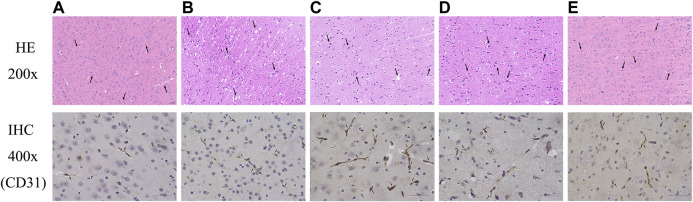
FYXN improved morphology and promoted angiogenesis in DMCI rats. Representative images of HE and immunohistochemistry are shown as follows: (A) DM sham group, (B) DMCI group, (C) FYXN group, (D) Nim & Met group and (E) NC group.